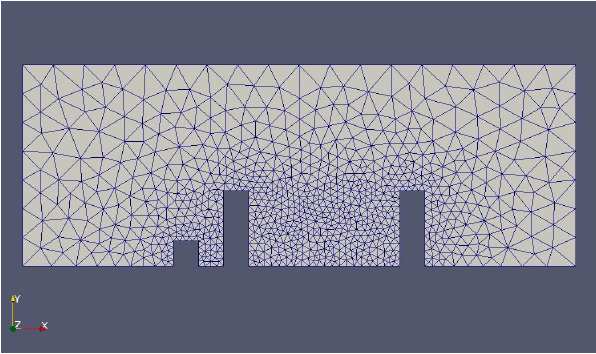
2D case representing 3 buildings. The mesh is unstructured as it is implemented in operational simulations. It includes 852